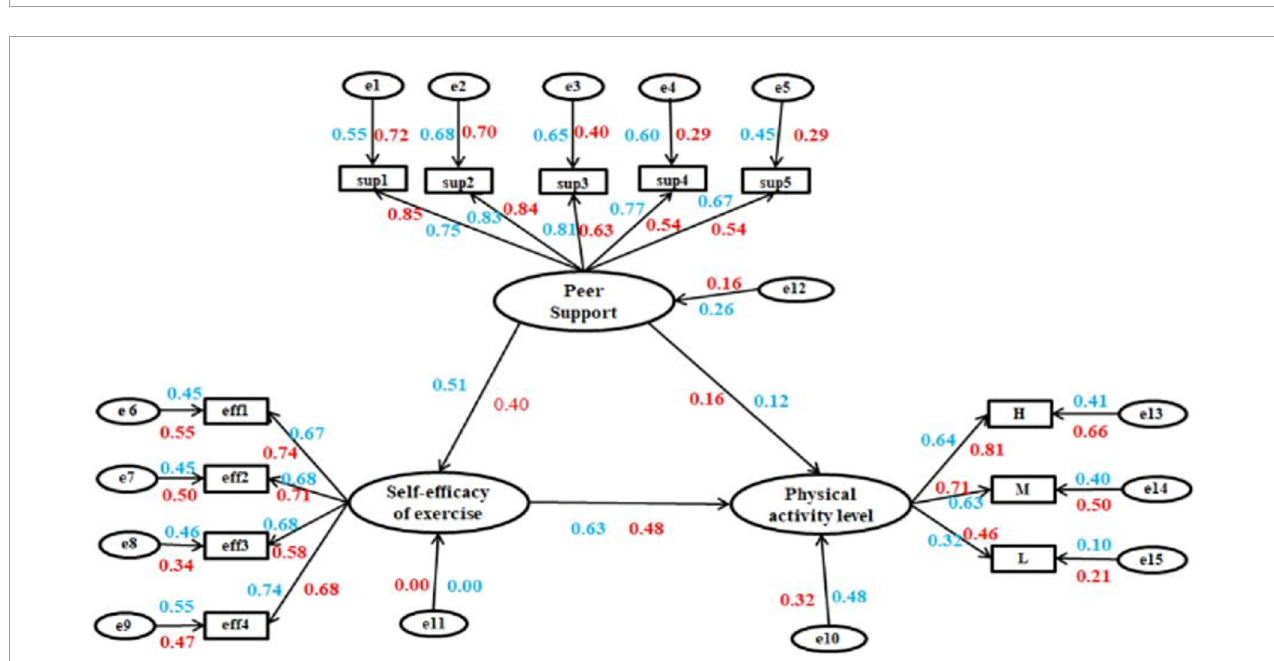
FIGURE3 The grouping structural equation model. The light blue represents the data of male college students, and red represents the data of female. In the male group: CMID/DF = 1.948, GFI = 0.905, AGFI = 0.855, RMSEA = 0.073, p = 0.001, CFI = 0.929, IFI = 0.932, RMSEA = 0.05–0.08, it indicated model-fit was good. In the female group: Model–fit indices was acceptable. CMID/DF = 2.204, GFI = 0.904, AGFI = 0.853, RMSEA = 0.083, p = 0.001, CFI = 0.908, IFI = 0.911, RMSEA = 0.08–0.10, it indicated that model-fit was